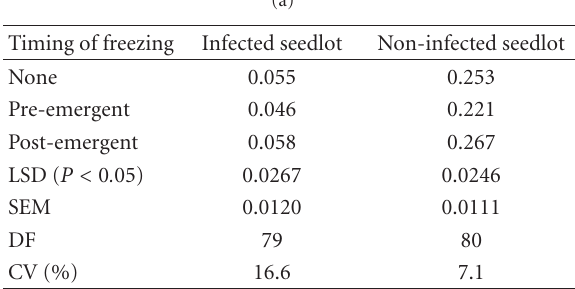
Table 1: E ff ect of timing (a) and duration (b) of freezing on rate of seedling emergence (seedlings day − 1 ) from a winter wheat cv. Equinox seed lot naturally infected (88%) with Microdochium spp. and a non-infected seed lot, and the timing of freezing ∗ duration of freezing interaction (c) on rate of seedling emergence (seedlings day − 1 ) from a non-infected winter wheat cv. Equinox seed lot.